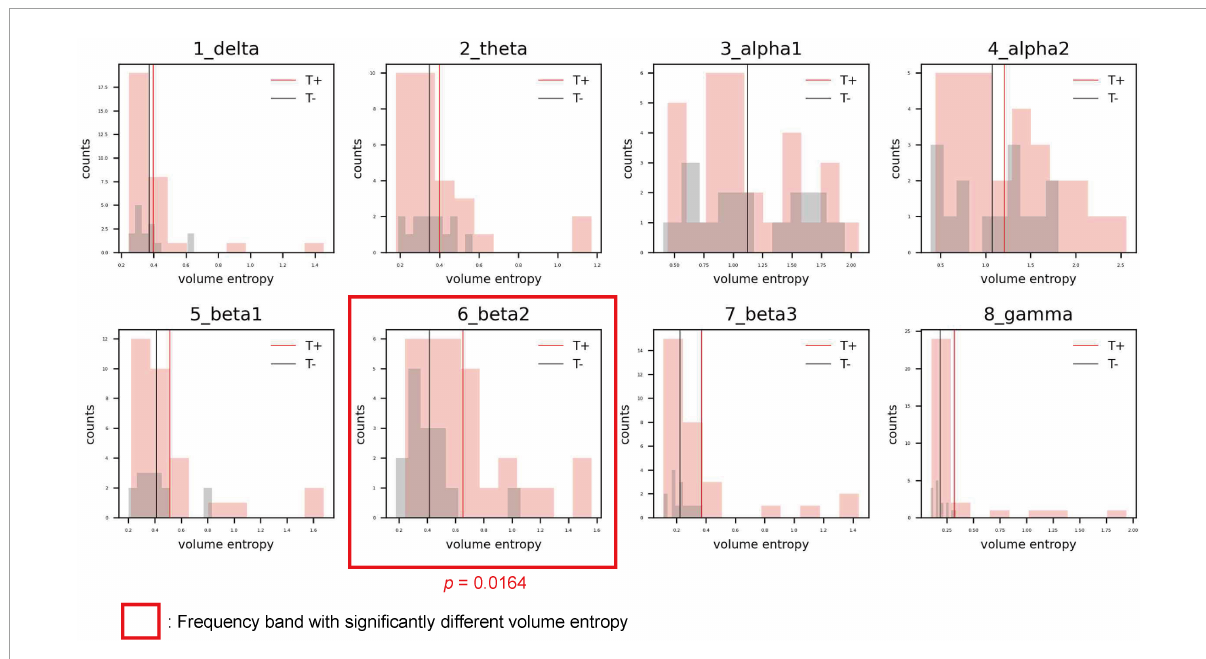
FIGURE1 Histograms showing the distribution of volume entropy for each frequency band in the sensorineural hearing loss with tinnitus (T; red) and sensorineural hearing loss without tinnitus (NT; black) groups. The red and black vertical lines indicate the average volume entropy in the T and NT groups,